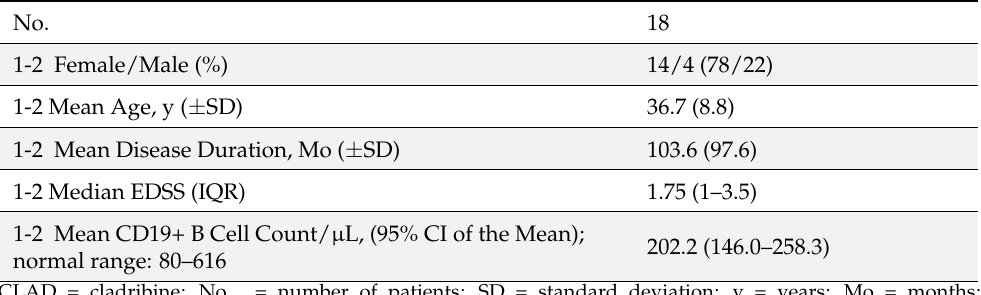
Table 1. Characteristics of the study population at the time of CLAD start